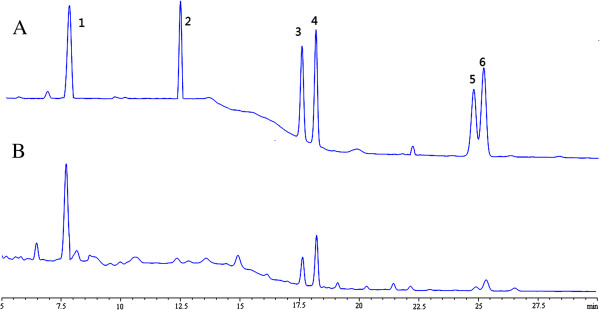
HPLC chromatogram of triterpenoid compositions in triterpenoid compound (TC). (A) standard triterpenoids; (B) TC. Peaks: 1: 1β, 2β, 3β, 19α-tetrahydroxy-12-en-28-oic acid; 2: tormentic acid; 3: maslinatic acid; 4: corosolic acid; 5: oleanolic acid; 6: ursolic acid.